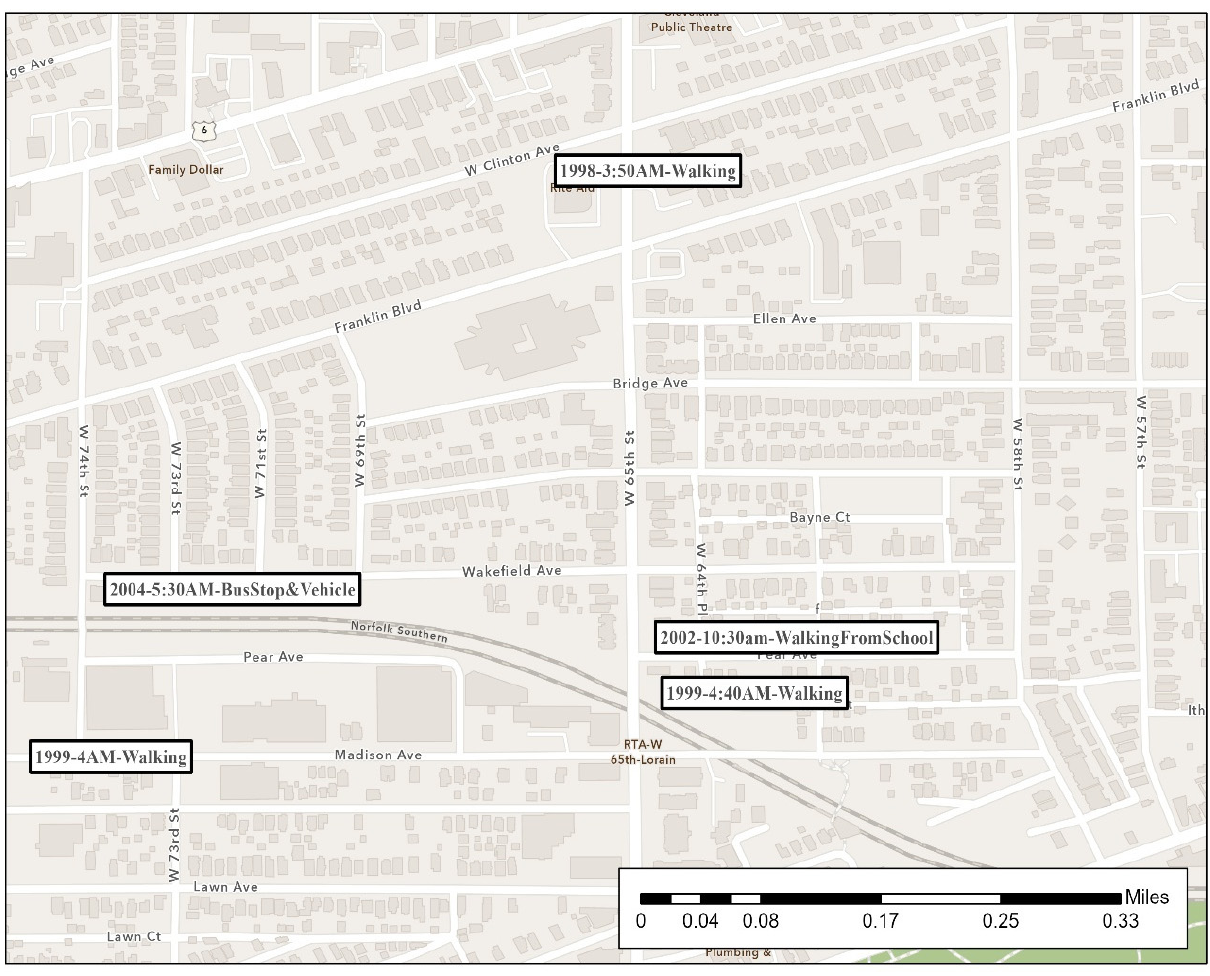
Figure 7. Cleveland’s West Side Favored Sexual Assault Locations.